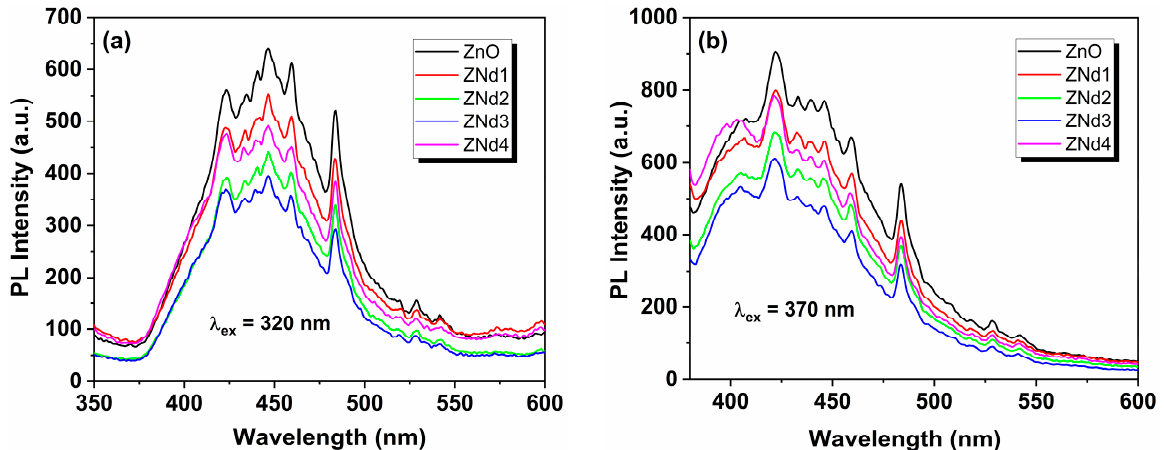
Figure 6. Photoluminescence spectra for pure ZnO and ZnO doped with various amounts of Nd ions (0.05, 0.1, 0.5, 1%) excited at wavelengths of 320 ( a ) and 370 nm ( b ).